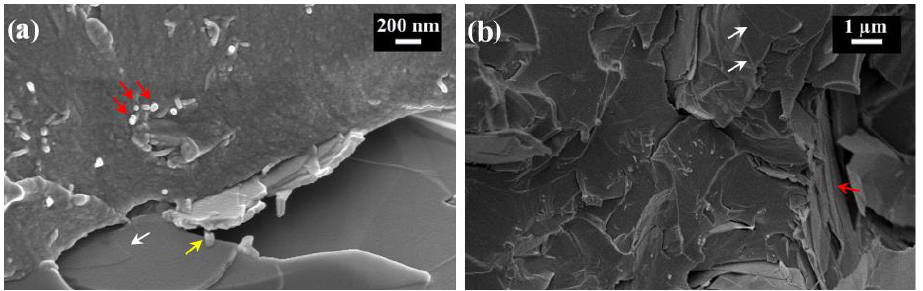
Figure 2. Fracture surface of composite with 0.1 wt.% of CNT plus 5 wt.% of graphite ( a ) and 0.1 wt.% of CNT plus 5 wt.% of GNP ( b ).